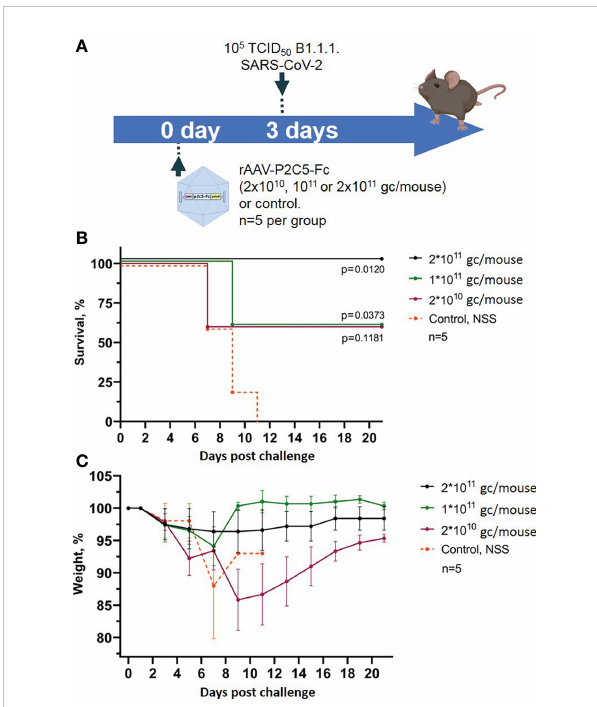
FIGURE 2 Evaluation of rAAV-P2C5-Fc optimal dose. (A) Scheme of the experiment: mice were treated with different doses of rAAV-P2C5- Fc and challenged with 10 5 TCID50 SARS-CoV-2 B.1.1.1 variant on day 3 after the transduction. (B) Animal survival. (C) Body weight loss. Lines – mean values, error bars – SD, numbers indicate statistical signi fi cance evaluated compared with the vehicle group using a logrank test. Data from different rAAV-P2C5-Fc treatment groups are shown by color. Control, NSS – mice received normal saline solution. n – number of animals per